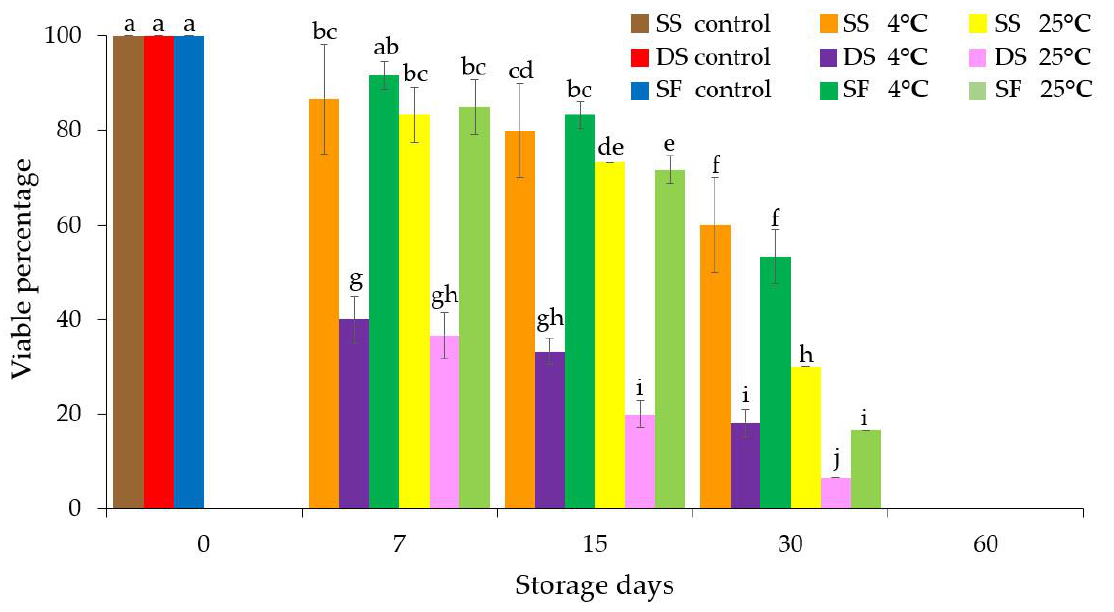
Figure 3. Percentages of viable Persian microshoots from synthetic seeds and fruit after storage at 4 °C and 25 °C for 0, 7, 15, 30 and 60 days. The viability test was based on staining the microshoots with 1% ( w/v ) 2,3,5-triphenyltetrazolium chloride. SS: a microshoot (synthetic seed) encapsulated with a single layer of alginate, DS: a single microshoot (synthetic seed) encapsulated with a double layer of alginate, SF: five microshoots encapsulated with a single layer of alginate (synthetic fruit). Data were means ± SD and those with different letters were significantly different ( p < 0.05 ).